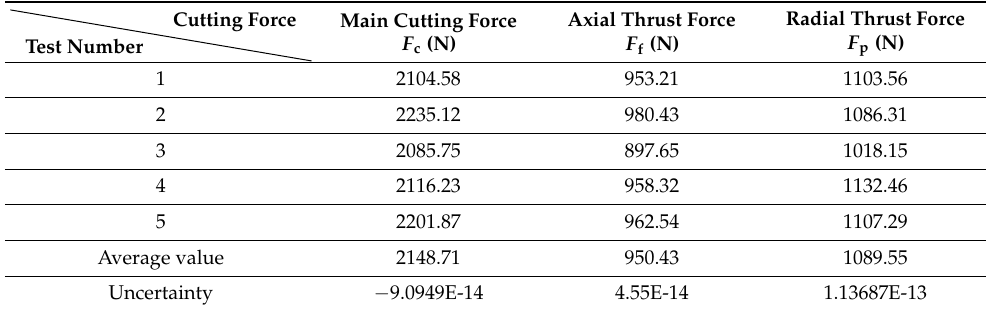
Table 3. Impact force collected from cutting